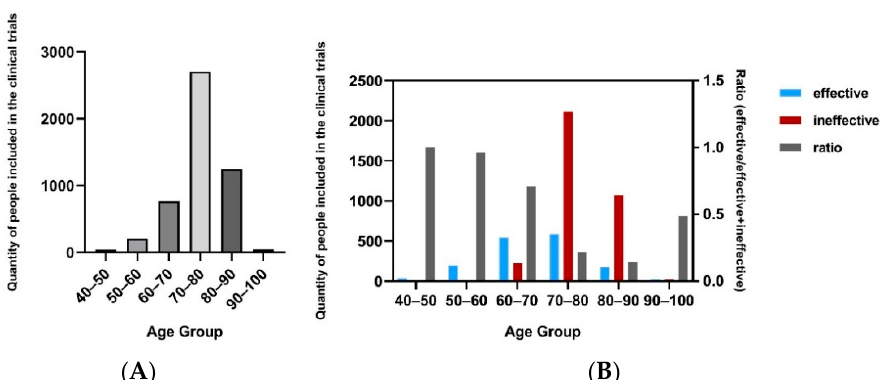
Figure 3. ( A ) The age distribution of all participants in clinical trials. ( B ) Comparison of age groups in clinical trial studies. in clinical trial